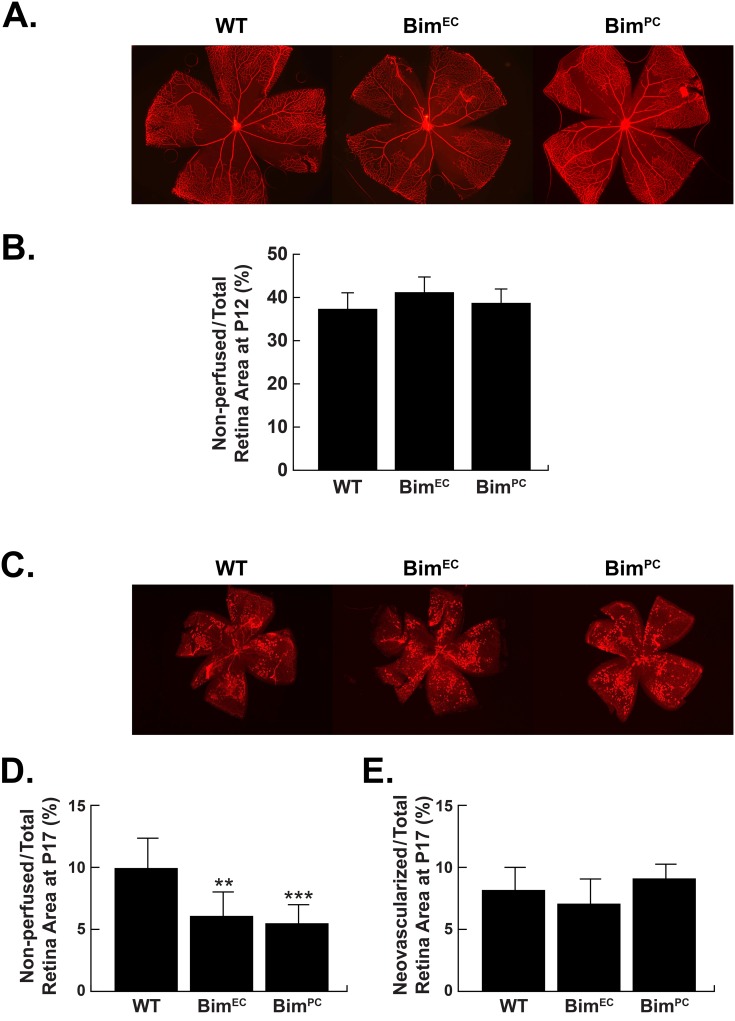
Lack of EC or PC Bim expression does not attenuate hyperoxia-driven vessel obliteration.Quantitative assessment of vessel obliteration and neovascularization in mice previously exposed to a cycle of hyperoxia and room air (OIR). Retinas from P12 and P17 BimFlox/Flox (WT) and conditional Bim littermates were wholemount stained with anti-collagen IV to visualize the vasculature (Panels A,C). The area of vessel obliteration relative to the whole retina was quantitated at P12 (n = 5, P>0.05, Panel B) and the non-perfused area remaining relative to the whole retina at P17 was quantitated (Panel D; n = 5, **P<0.01, ***P<0.001). Panel E is a quantitative assessment of the neovascularization (n = 5, P> 0.05). For Panel A magnification is at 2.5 X while Panel C is at 1.25 X.